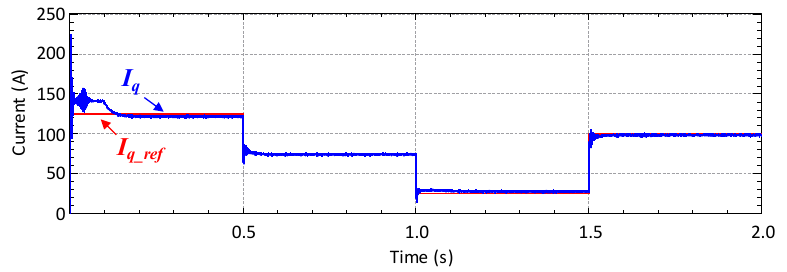
Figure 16. Simulation results of the q -axis currents I q_ref and I q for different mechanical loads.